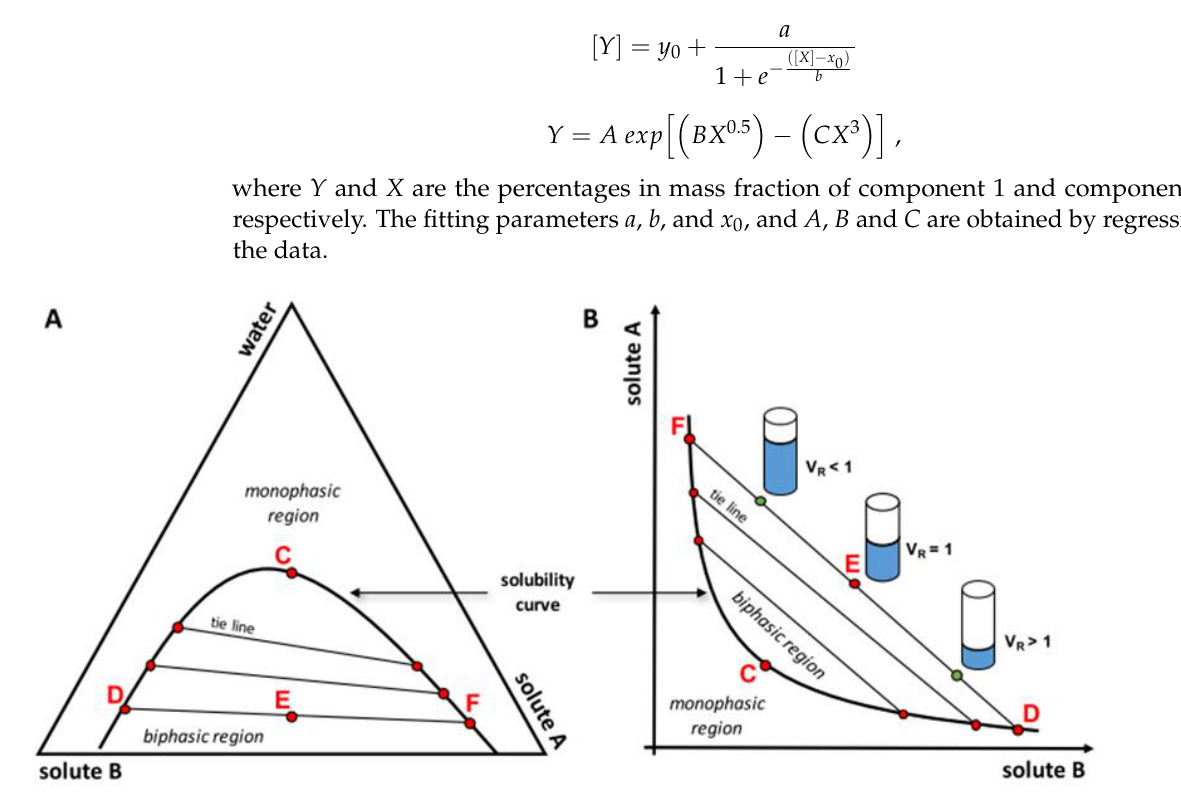
Figure 1. Ternary phase diagram for a hypothetical system composed of solute A + solute B + water. ( A ) triangular phase diagram; ( B ) orthogonal phase diagram; ( C ) binodal curve; ( D ) Composition of solute B-rich phase; ( E ) Composition of initial mixture; ( F ) Composition of solute A-rich phase.